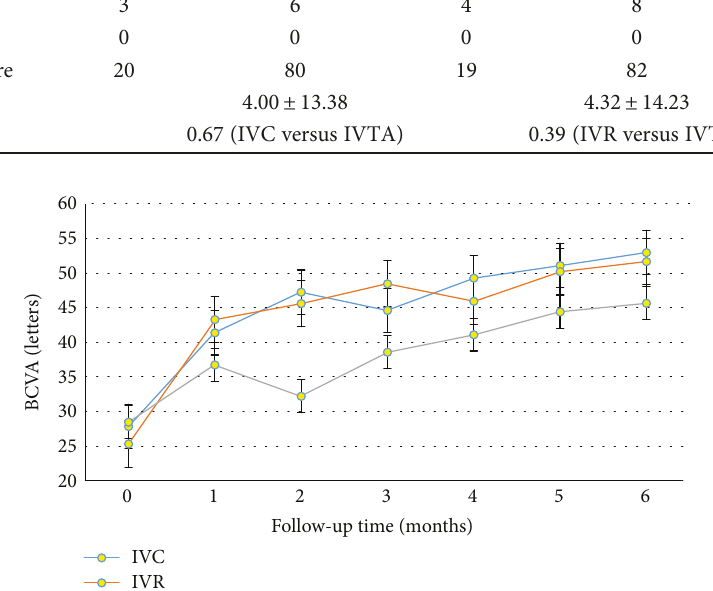
Figure 2: The mean changes in BCVA from baseline in IVC, IVR, and IVTA groups over 6m were as indicated by the ETDRS chart letters. BCVA gradually increased after treatments in all three groups. The increases of BCVA were the most at the end of the fi rst month. At the end of 6 m, the mean BCVA was improved by 25.10 ± 3.73, 26.32 ± 4.06, and 17.16 ± 2.87 letters in IVC, IVR, and IVTA groups, respectively (all P values <